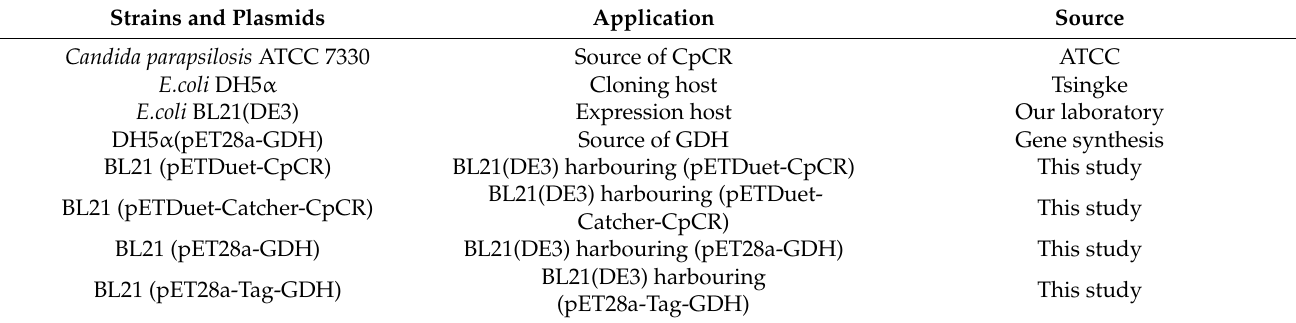
Table 1. Strains used in the experiment.